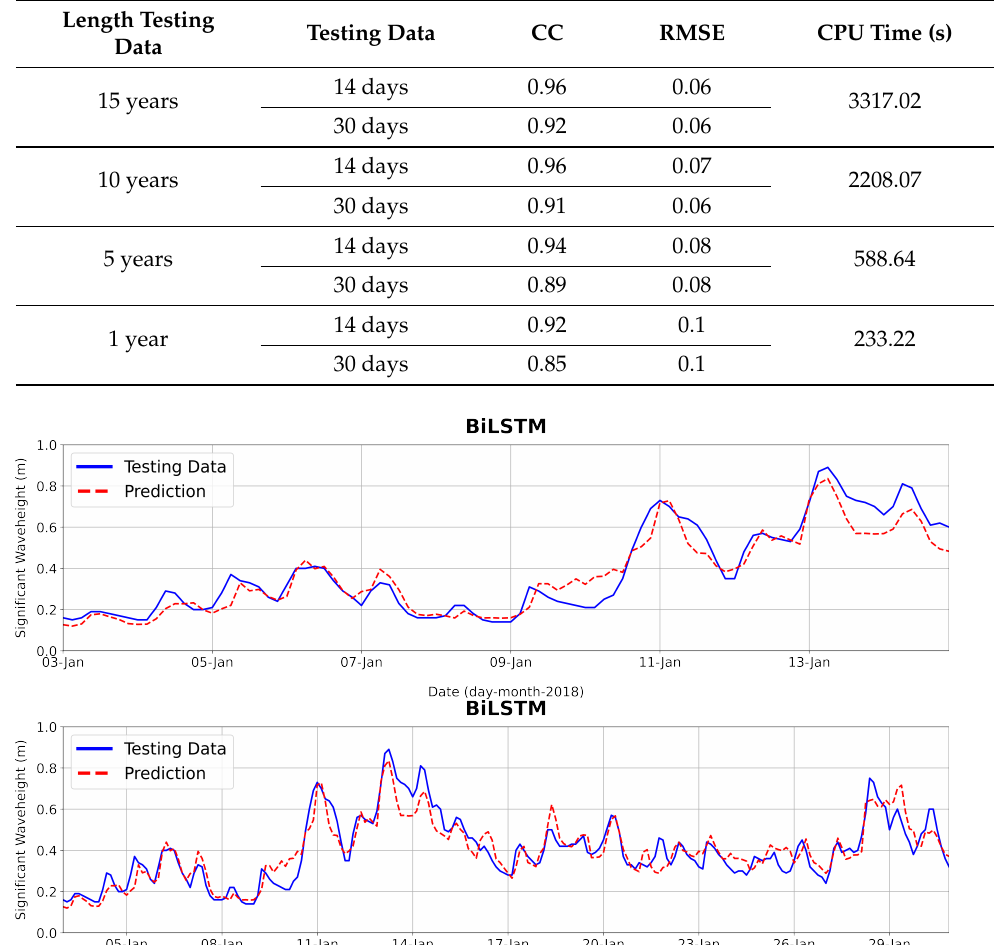
Table 3. Training data versus testing data variation.